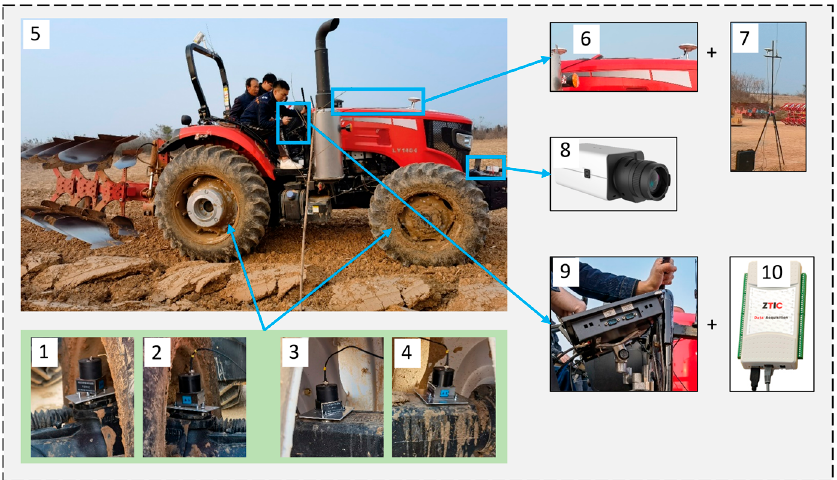
Figure 3. The sensor installation diagram of the experimental tractor: 1. Vibration sensor for front axle (left), 2. Vibration sensor for front axle (right), 3. Vibration sensor for rear axle (left), 4. Vibration sensor for rear axle (right), 5. Experimental tractor, 6. GPS mobile station antenna, 7. GPS base station antenna, 8. Video camera, 9. Tractor touch vehicle terminal, 10. Vibration signal data acquisition system.